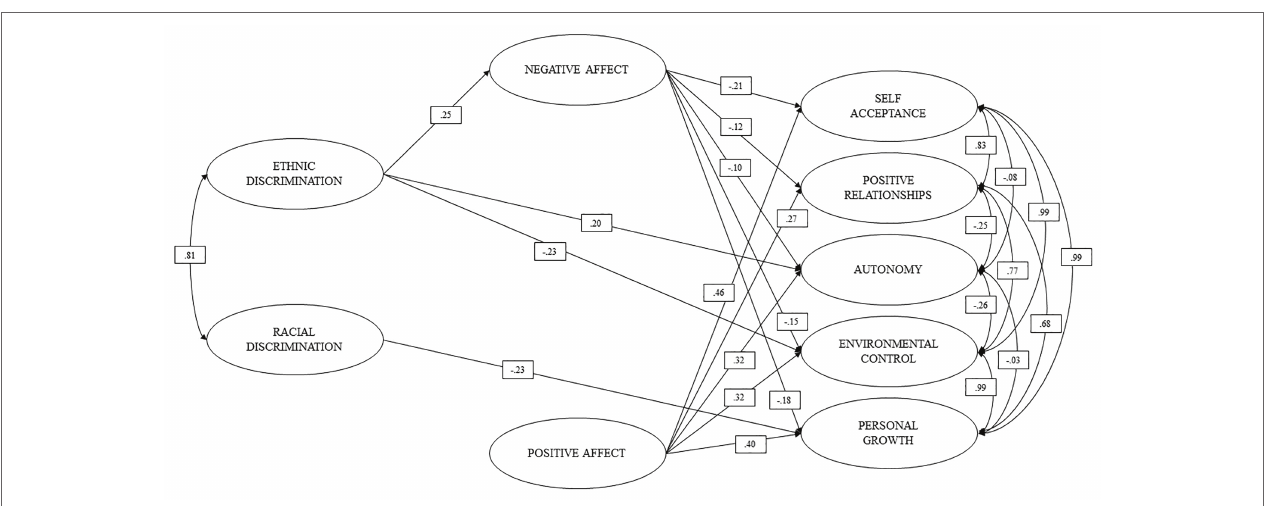
FIGURE 3 | Model of multiple mediations.